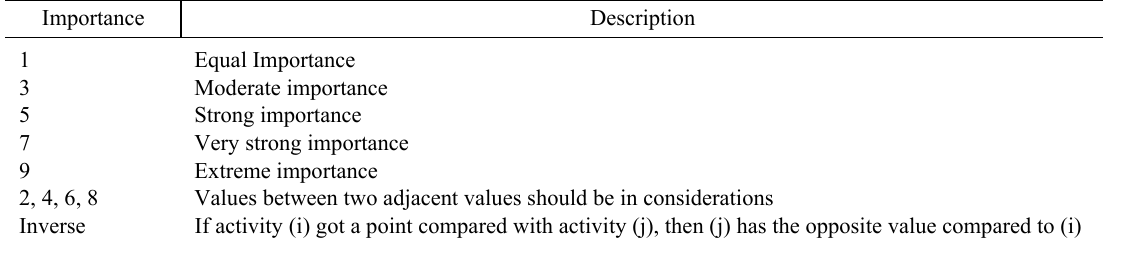
Table 2. Pair-wise comparison scale